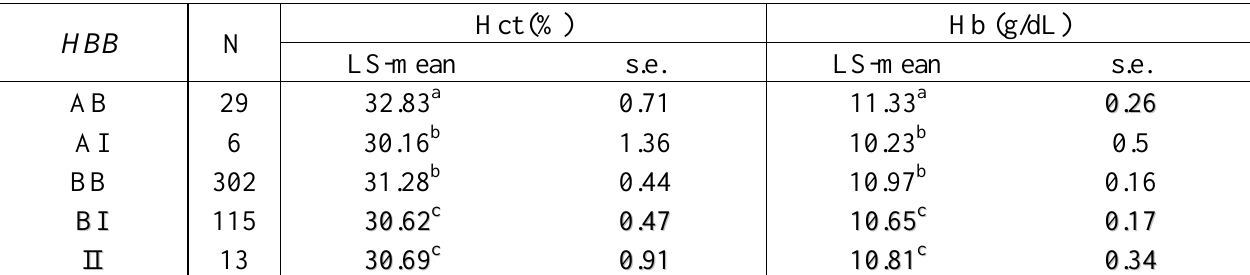
Table 11. Least-square means (LS-mean) and standard error (s.e.) of hematocrit value (Hct) and hemoglobin value (Hb) for HBB genotype in sheep. Means with different superscripts differ significantly (P <